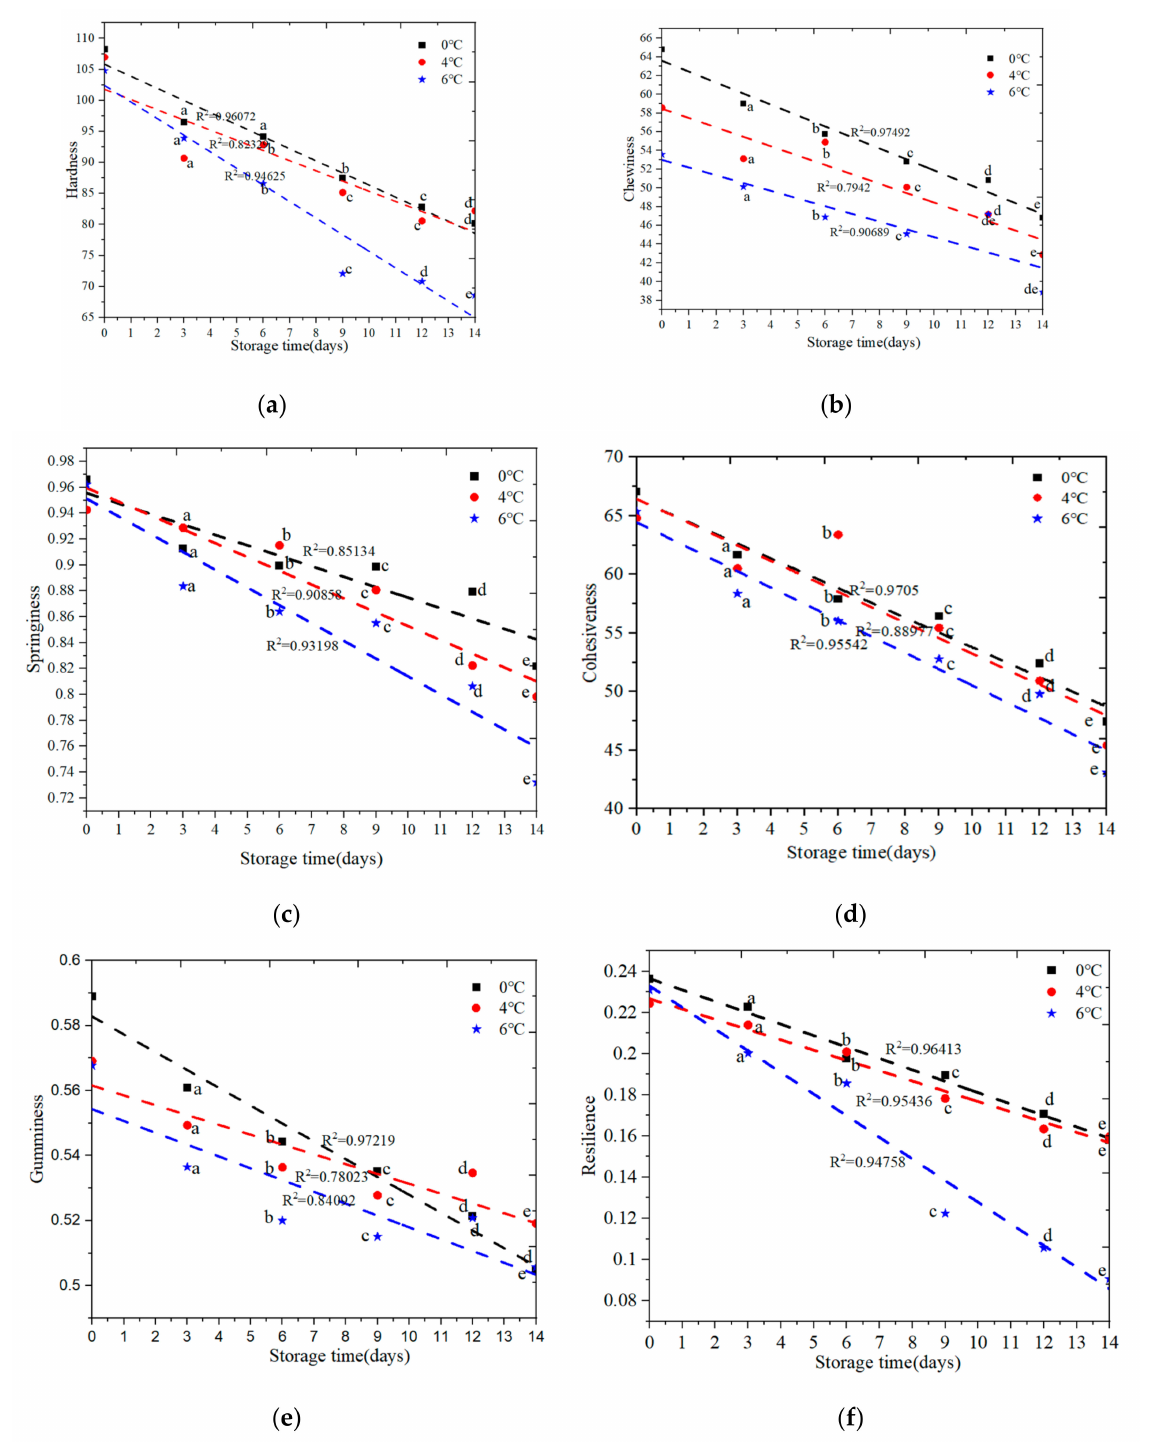
Figure 6. Changes in texture attributes of salmon samples stored at 0 ◦ C, 4 ◦ C and 6 ◦ C, respectively. ( a ) Change in hardness of salmon; ( b ) Change in chewiness of salmon; ( c ) Change in springiness of salmon; ( d ) Change in cohesiveness of salmon; ( e ) Change in gumminess of salmon; ( f ) Change in resilience of salmon. Note: di ff erent letters present significant ( p < 0.05) di ff